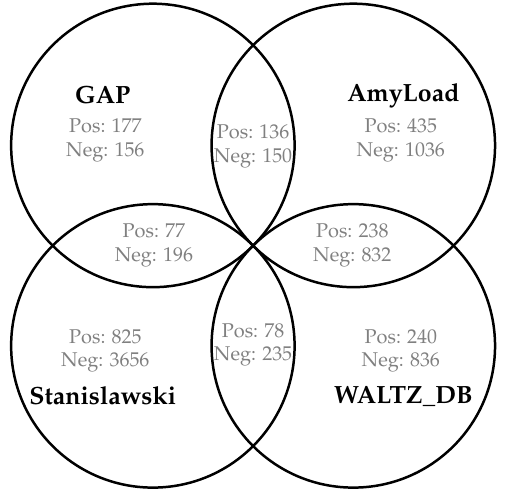
Figure 4. Combined amyloid databases used in this work. Pos and Neg denote, respectively, positive and negative word counts in the